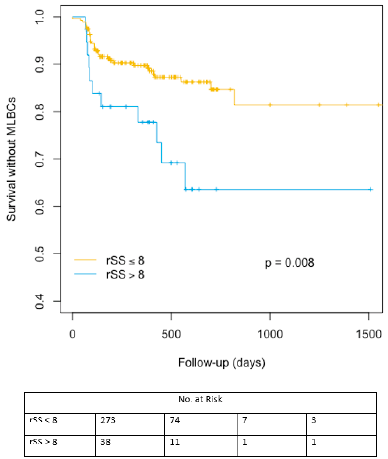
Figure 3. Cumulative incidence analysis for major/life-threatening bleeding events-free survival after TAVR according to rSS cut off value of 8. MLBCs: Major/life-threatening bleeding events-free survival, rSS: residual Syntax Score.